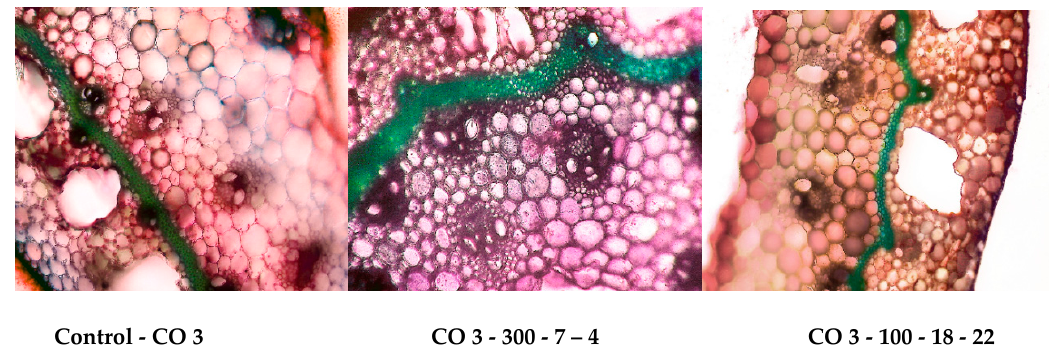
Figure 6. Cross-section of the extreme mutants depicting the thickness of the sclerenchyma cell along with the wild type (CO 3).